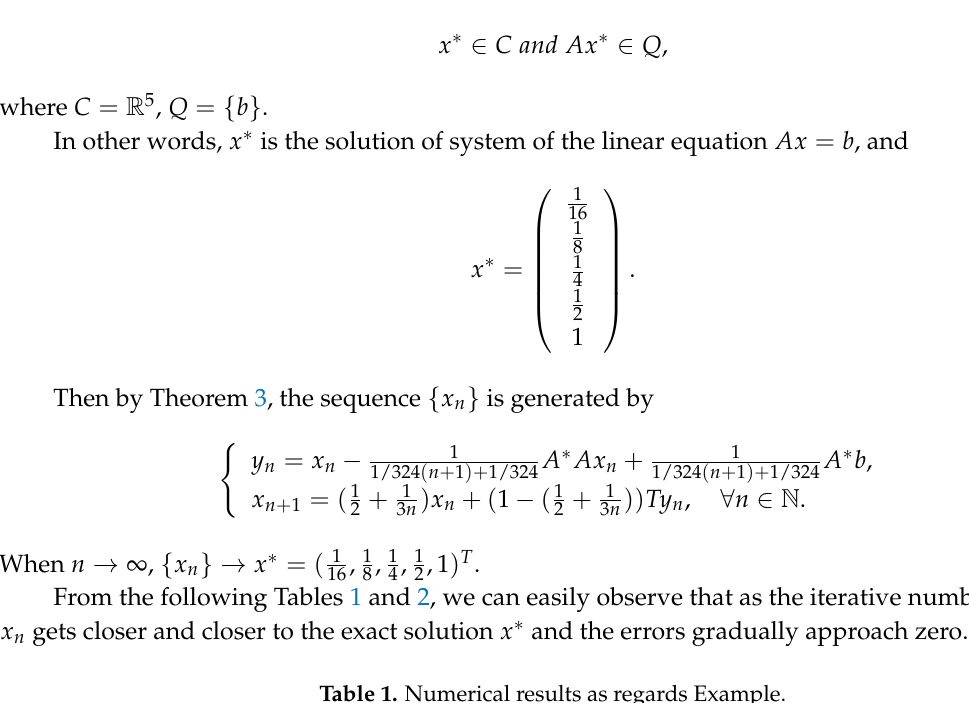
Table 1. Numerical results as regards